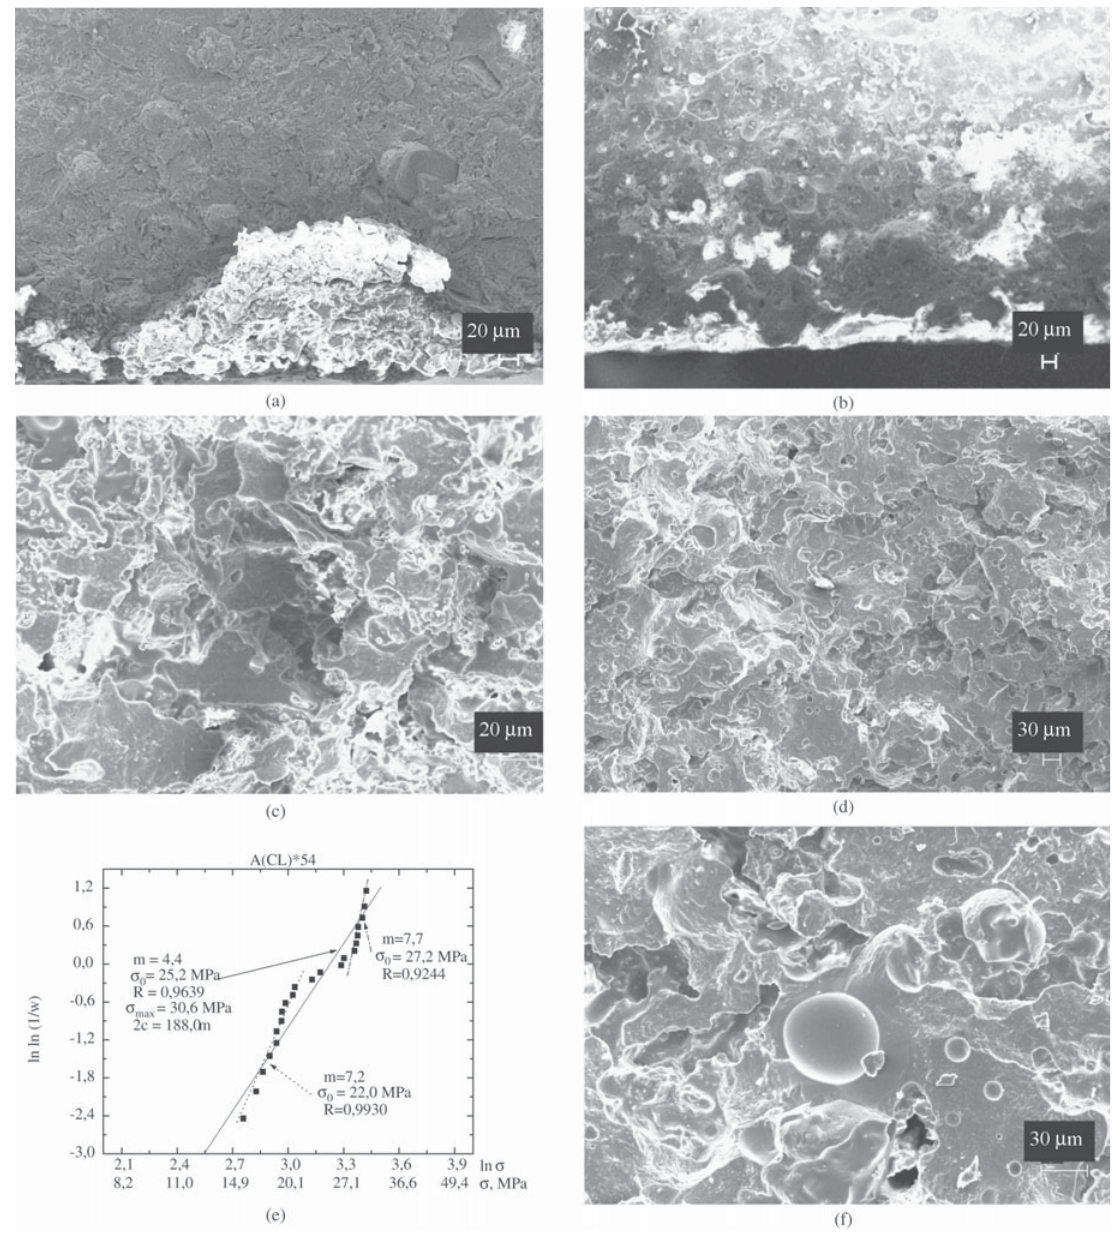
Figure 9. Scanning electron micrographies of the fracture surface of some ceramics sintered at 1200 °C, and the bimodal Weibull distri- bution of clay + 54% (CL)* ash: a) Pure clay; b) clay 20% F 20% (CL)*ash; c) clay 54% (CL)*ash: sample at the lower mode of BWD; d) Clay 54% (CL)*ash: sample at the higher mode of BWD; e) bimodal Weibull distribution of the clay + 54%(CL)*ash; f) Clay 54% (CL)*ash: immiscibility of glass in